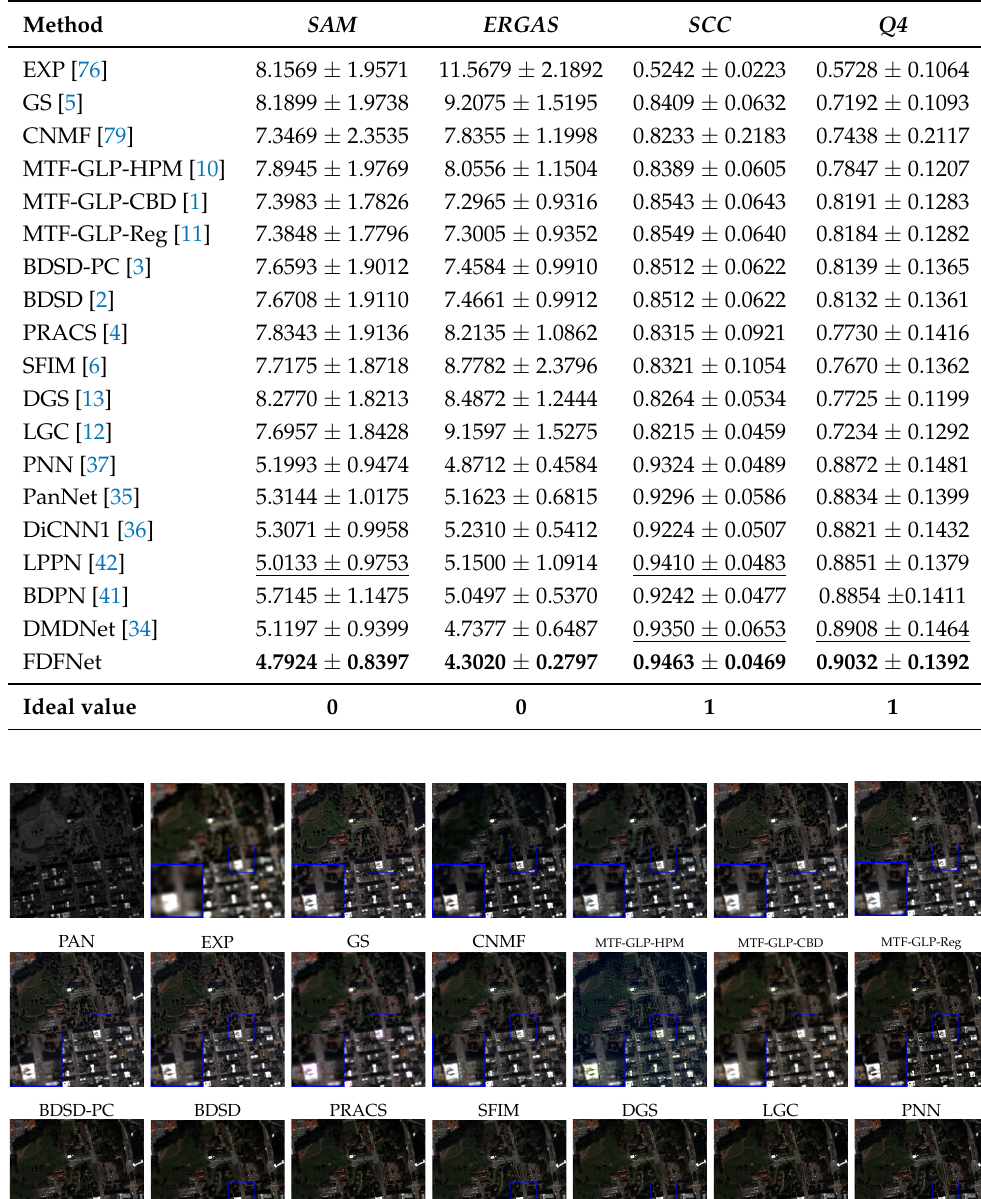
Table 3. Average quantitative with the related standard deviations (std) comparisons on 48 reduced- resolution QB examples. The best performance is shown in bold and second place is underlined.